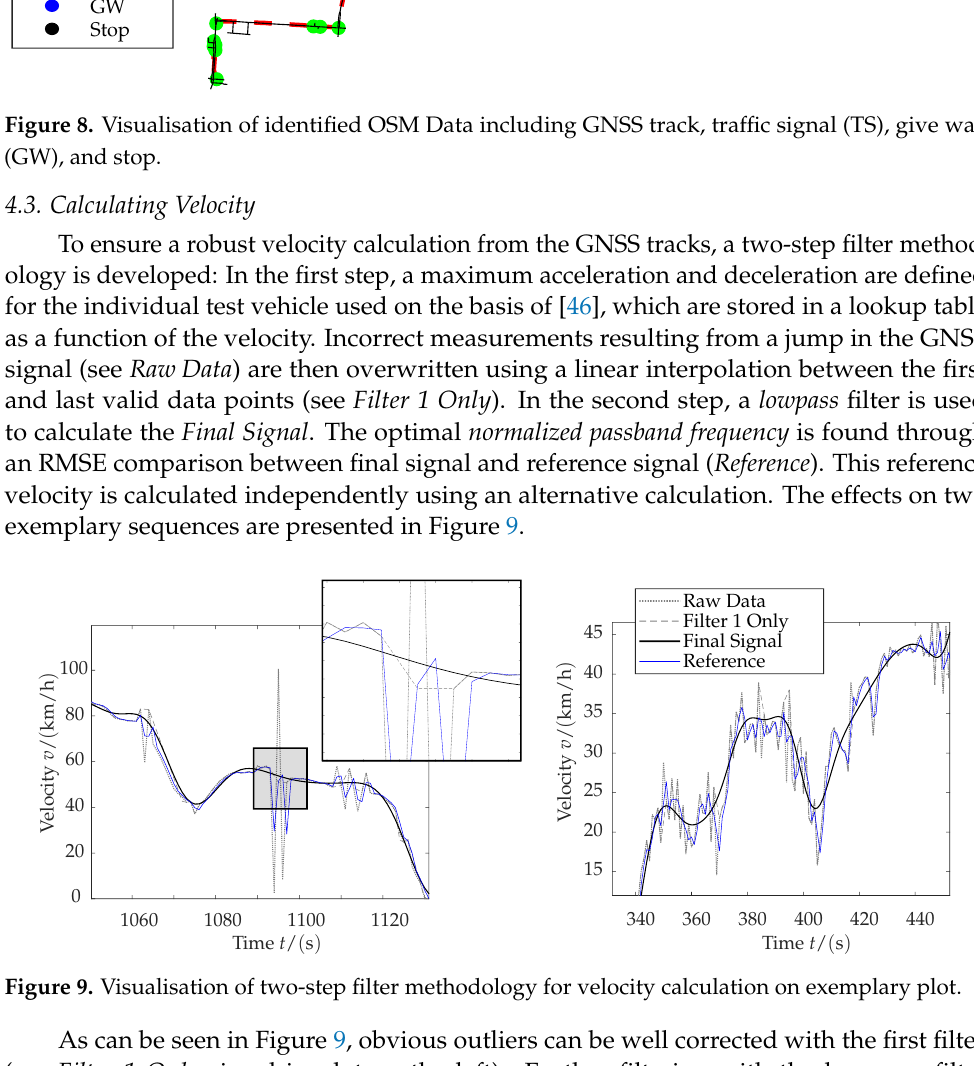
Figure 9. Visualisation of two-step filter methodology for velocity calculation on exemplary plot